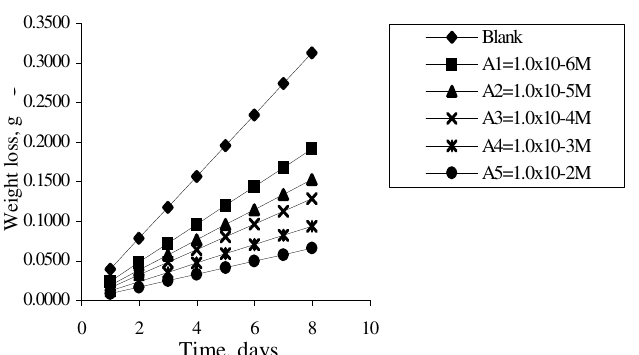
Figure 5. Variation of weight loss (g) with time (days) for mild steel coupons in 2 M HCl solutions containing 2-benzoylpyridine at 303K.